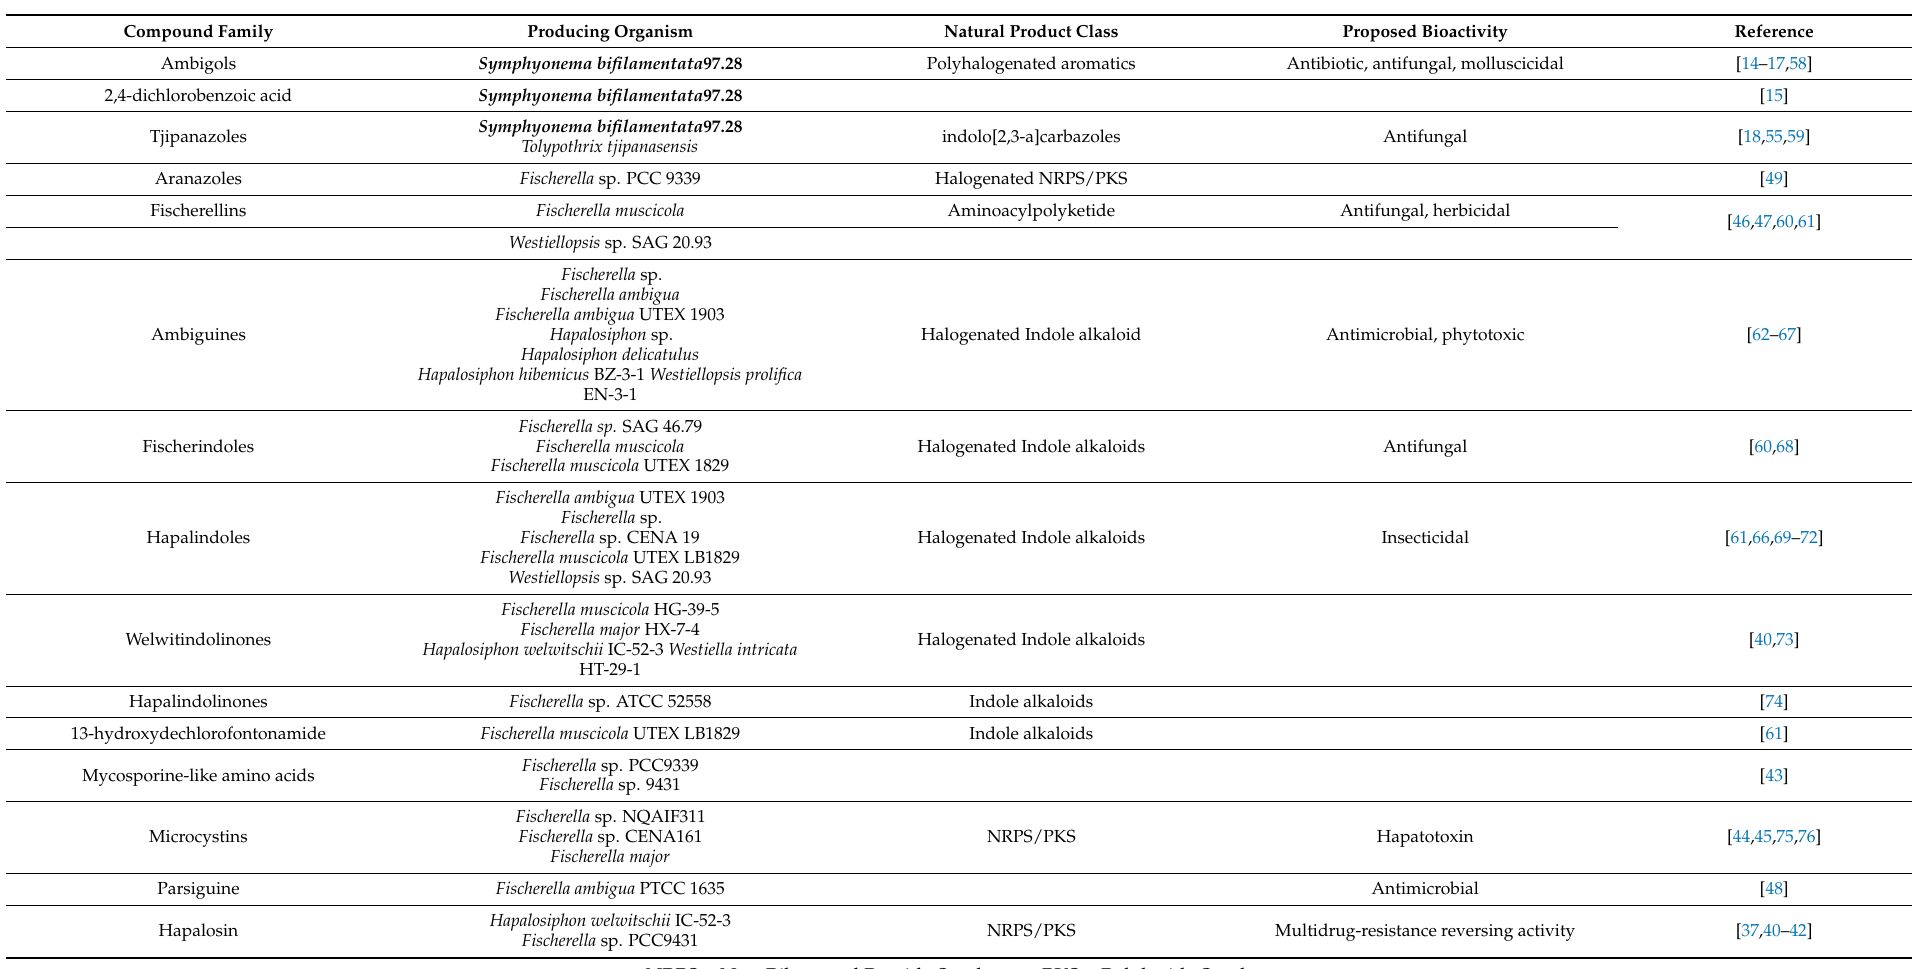
Table 2. Summary of natural products produced by Symphyonema bifilamentata 97.28 compared to those produced by related species from